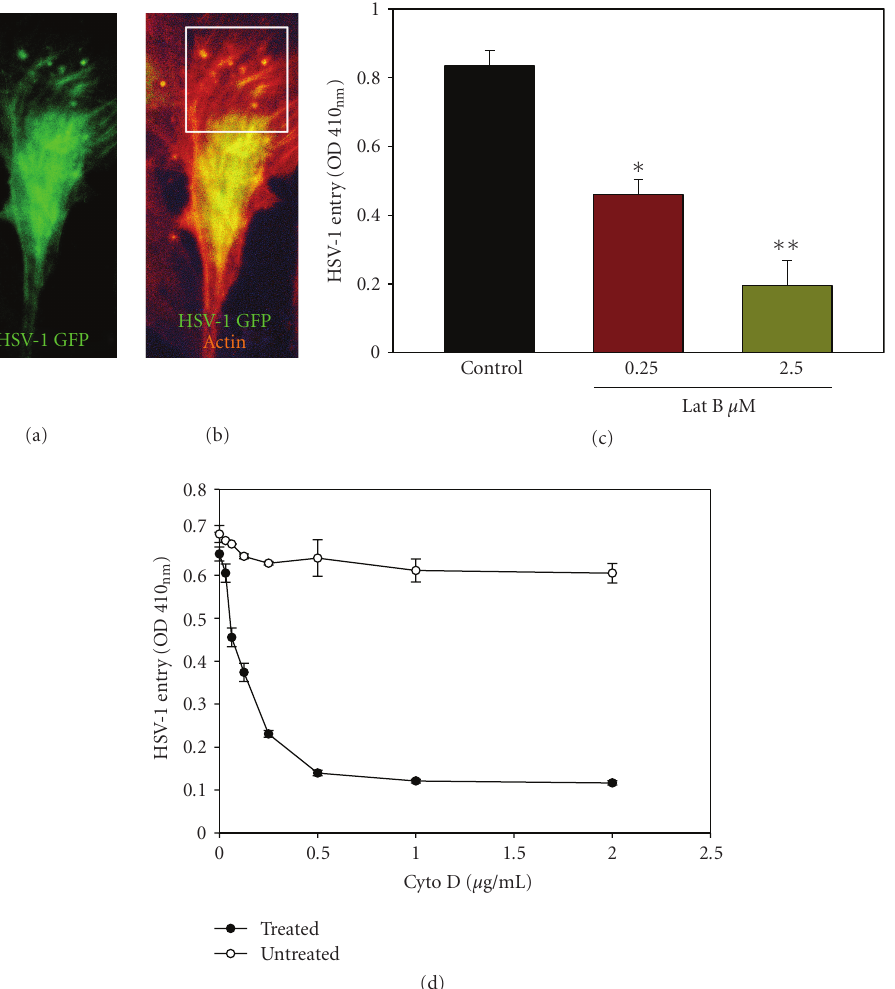
Figure 2: HSV-1 entry into hMSCs is cytoskeleton dependent. (a) An infected cell showing the virus particles (green). Cells were infected with HSV-1 (K26GFP) at 50PFU/cell and imaged 45 min postinfection. (b) Virus particles colocalize with F-actin in filopodia-like structures (boxed area). F-actin was stained by rhodamine phalloidin (red). Areas where virus particle (green) and F-actin overlap appear yellow. (c) HSV-1(KOS) gL86 entry into hMSCs (50PFU/cell) was inhibited by actin depolymerizing agent Latrunculin B (Lat B) in a dose-dependent manner. (d) HSV-1(KOS) gL86 entry into hMSCs (50PFU/cell) was inhibited by actin depolymerizing agent Cytochalisin D (Cyto D) in a dose-dependent manner. The mock-treated hMSCs were used as a control. Viral entry was quantitated 6h after infection at 410 nm using a spectrophotometer ∗ P < . 05, ∗∗ P < .